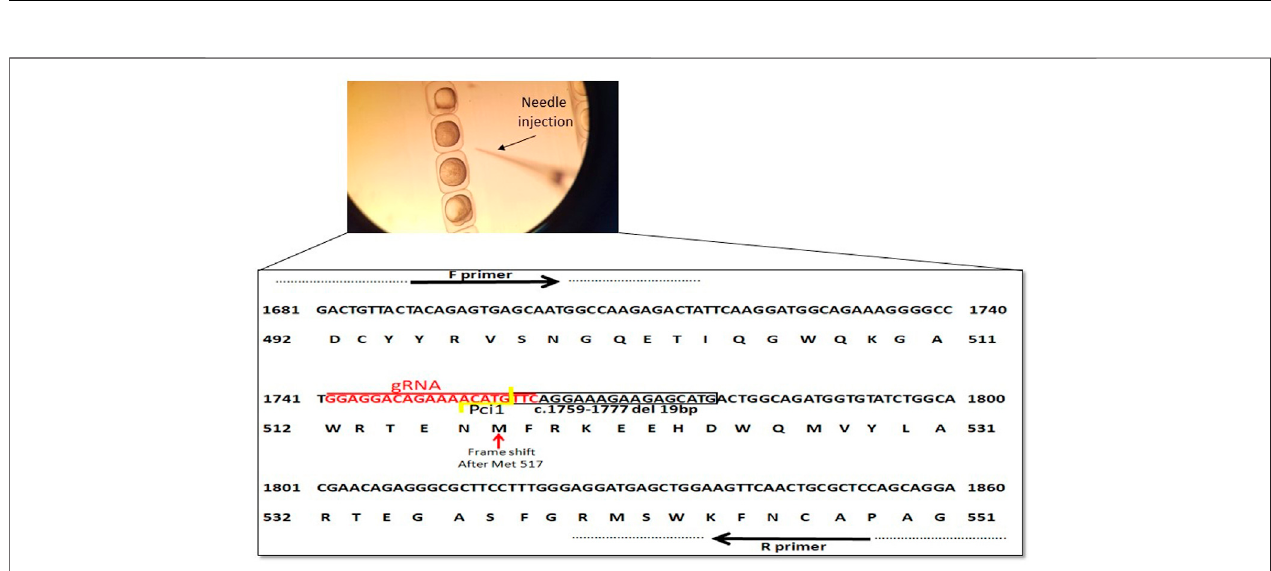
FIGURE 2 | Schematic representation of ngly1 gene targeting in zebra fi sh. CRISPR/Cas9 gRNA in exon9 (in red), deletion of 19bp (c.1759 – 1777) is marked by black box and frameshift starting point is indicated by red arrow. Primers used for PCR ampli fi cation are marked.